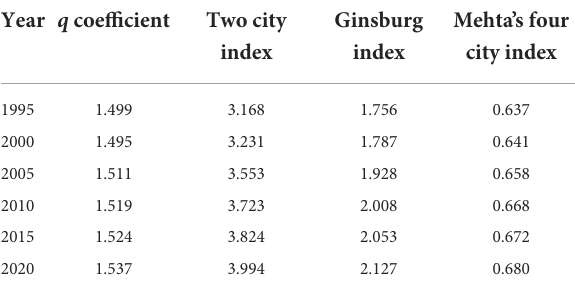
TABLE 2 Changes in q coefficients and urban primacy indices (FUAs